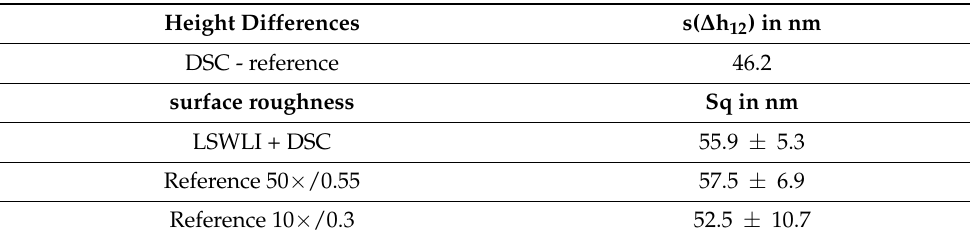
Table 2. Standard deviations of the height differences between LSWLI topography and vertical scanning white light interferometry (VSWLI) reference topography. The standard deviation of each topography by itself is given as a figure of merit for the surface